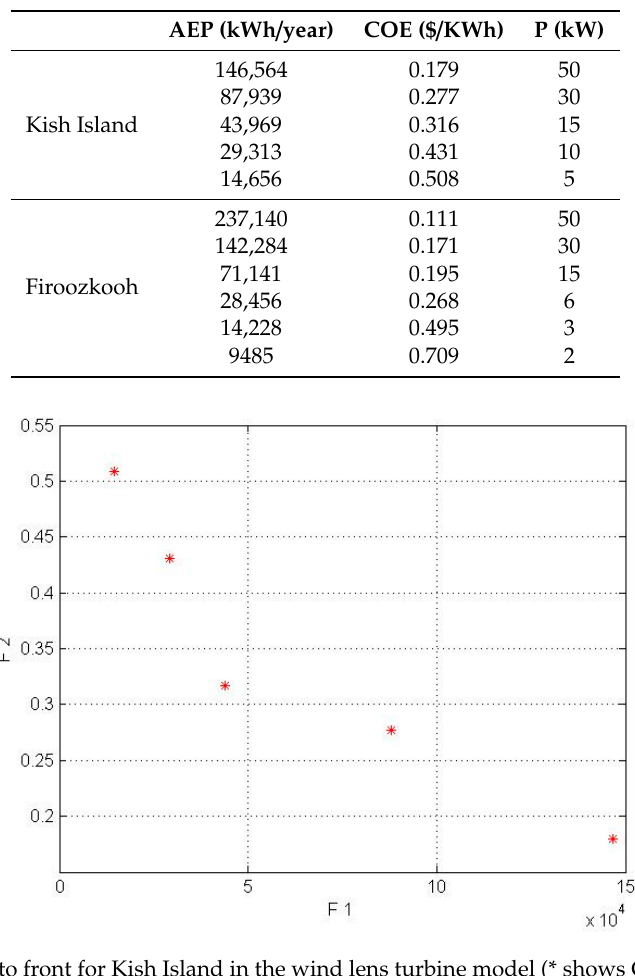
Table 7. The Pareto front results for wind lens turbines.